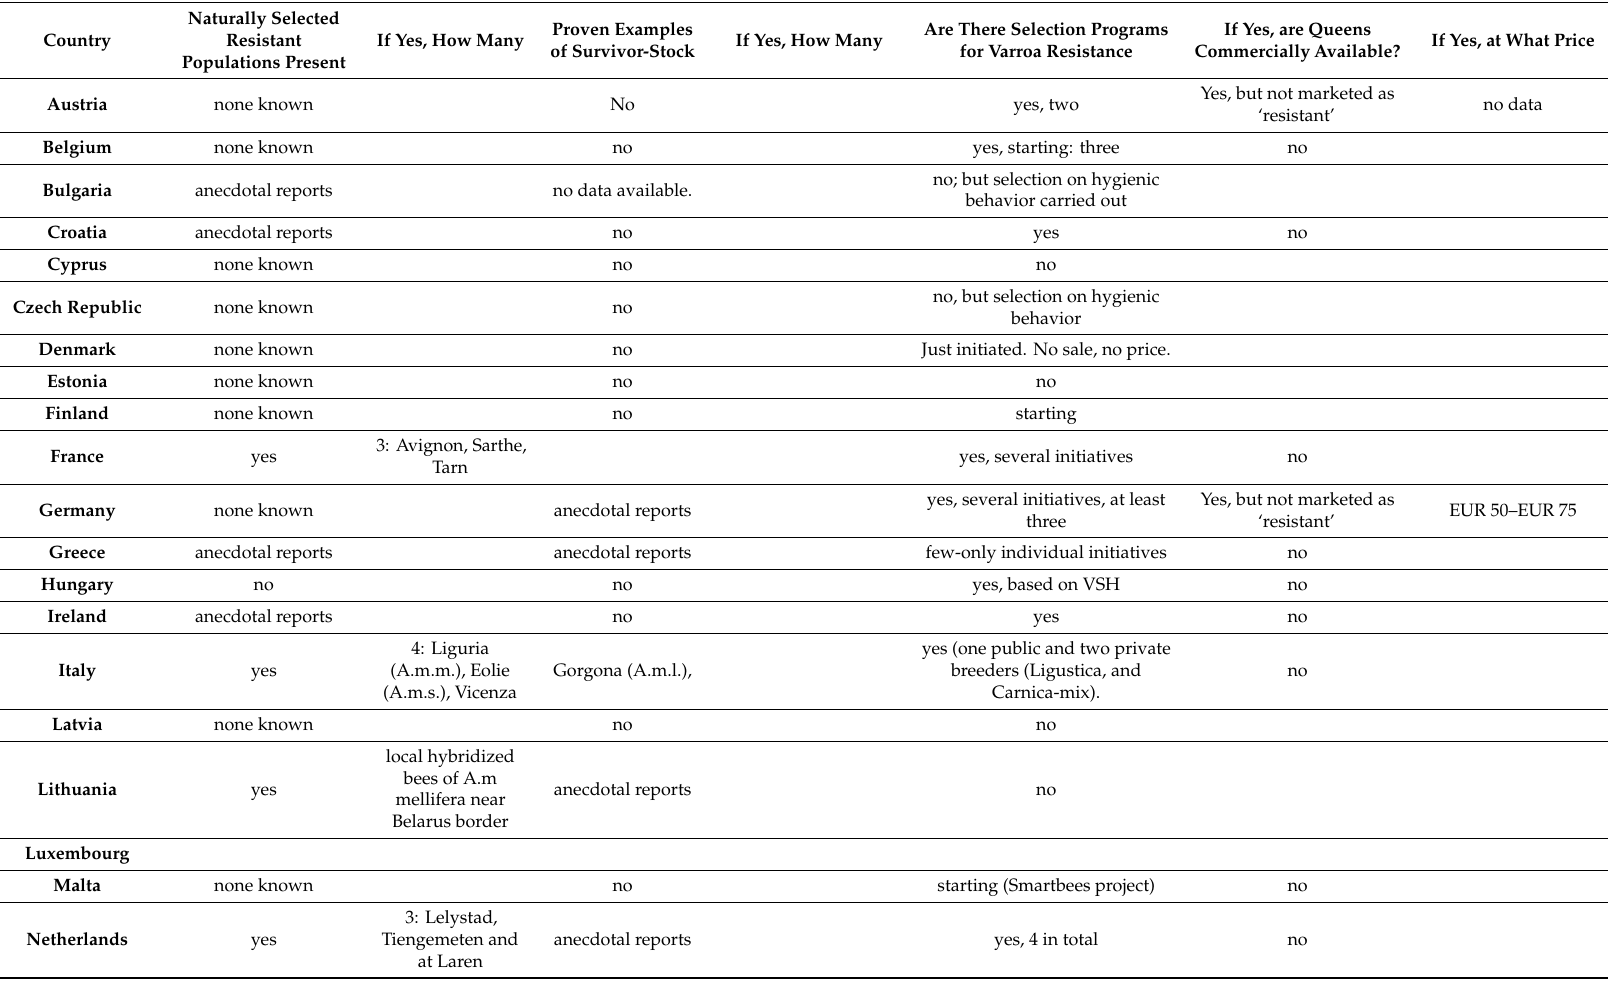
Table 2. Overview of varroa-resistant populations of honey bees in Europe, both naturally selected and from selection programs, and their commercial availability for